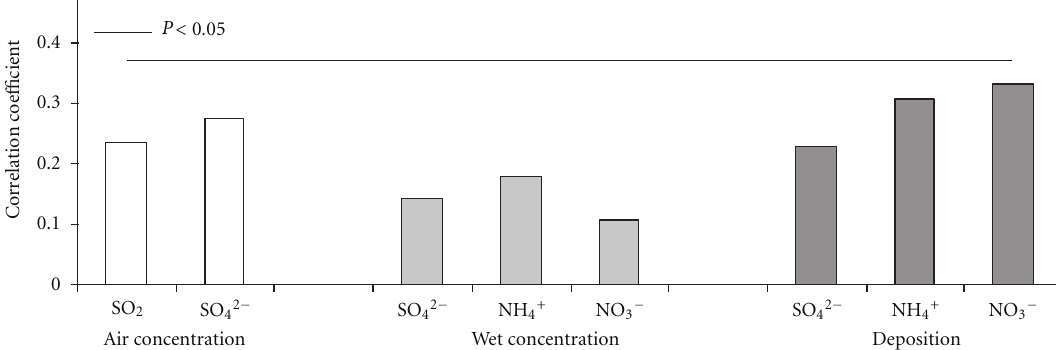
Figure 6: E ff ect of the main acidifying species in the air, precipitation, and their deposition on beech tree radial growth.